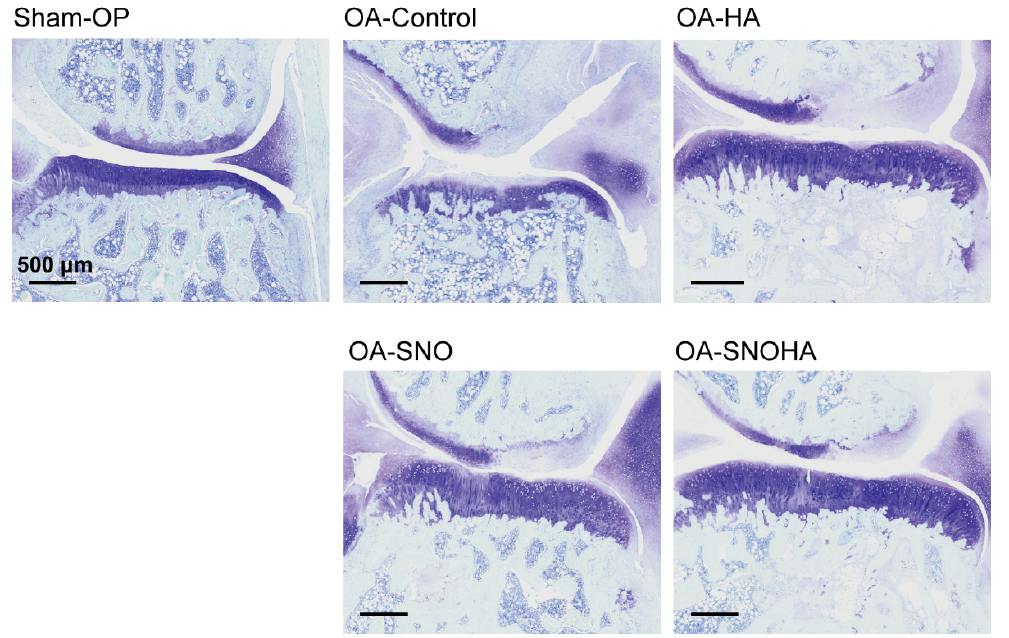
Figure 5. Representative section of medial tibial cartilage from each treatment (OA-HA, OA-SNO, and OA-SNOHA) and control (sham-OP, OA-control) were shown. Scale bar = 500 µ m.